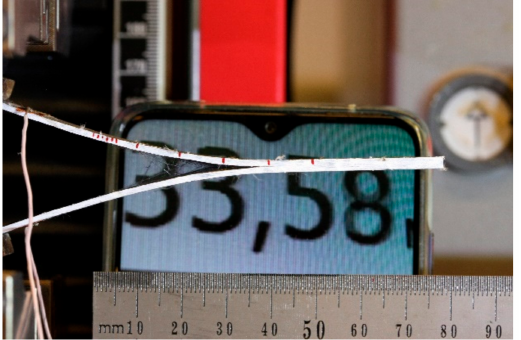
Figure 14. DCB specimen of GFRP with built-in foil electrodes during Mode I interlaminar fracture toughness